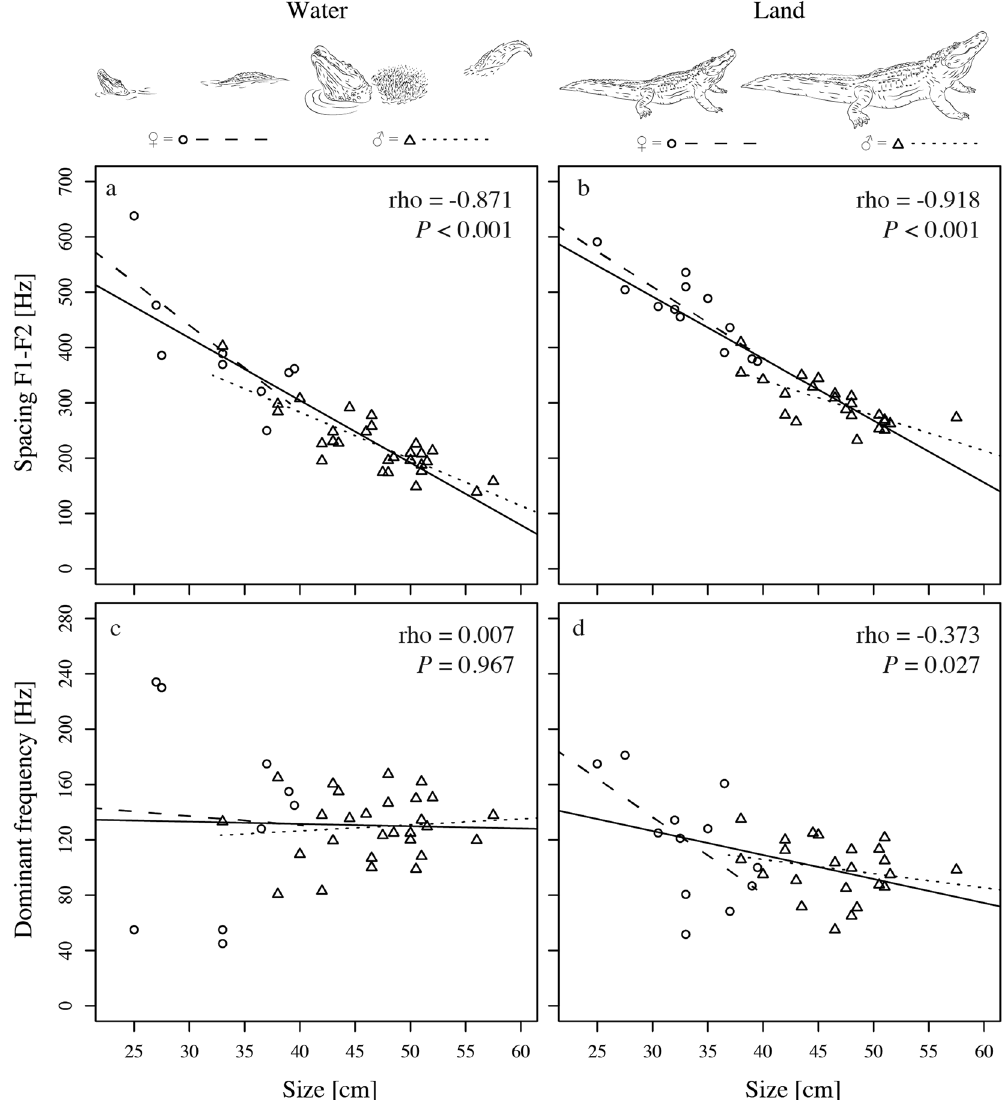
Figure 3. The spacing between the first two formants F1F2 (upper panels) was strongly inversely correlated with size in water ( a ) and on land ( b ) for both sexes. The dominant frequency (lower panels) showed no correlation with size in water ( c ) but correlated weakly for bellows produced on land ( d ). (size represented with DCL, drawings by